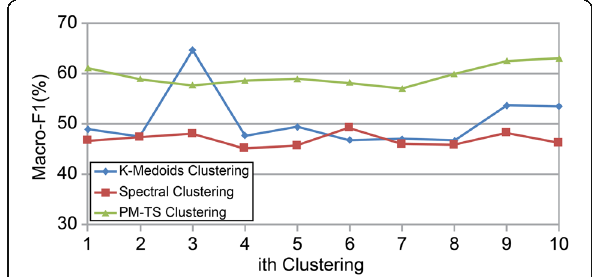
Fig. 10 Macro-F1 of the three algorithms, run ten times